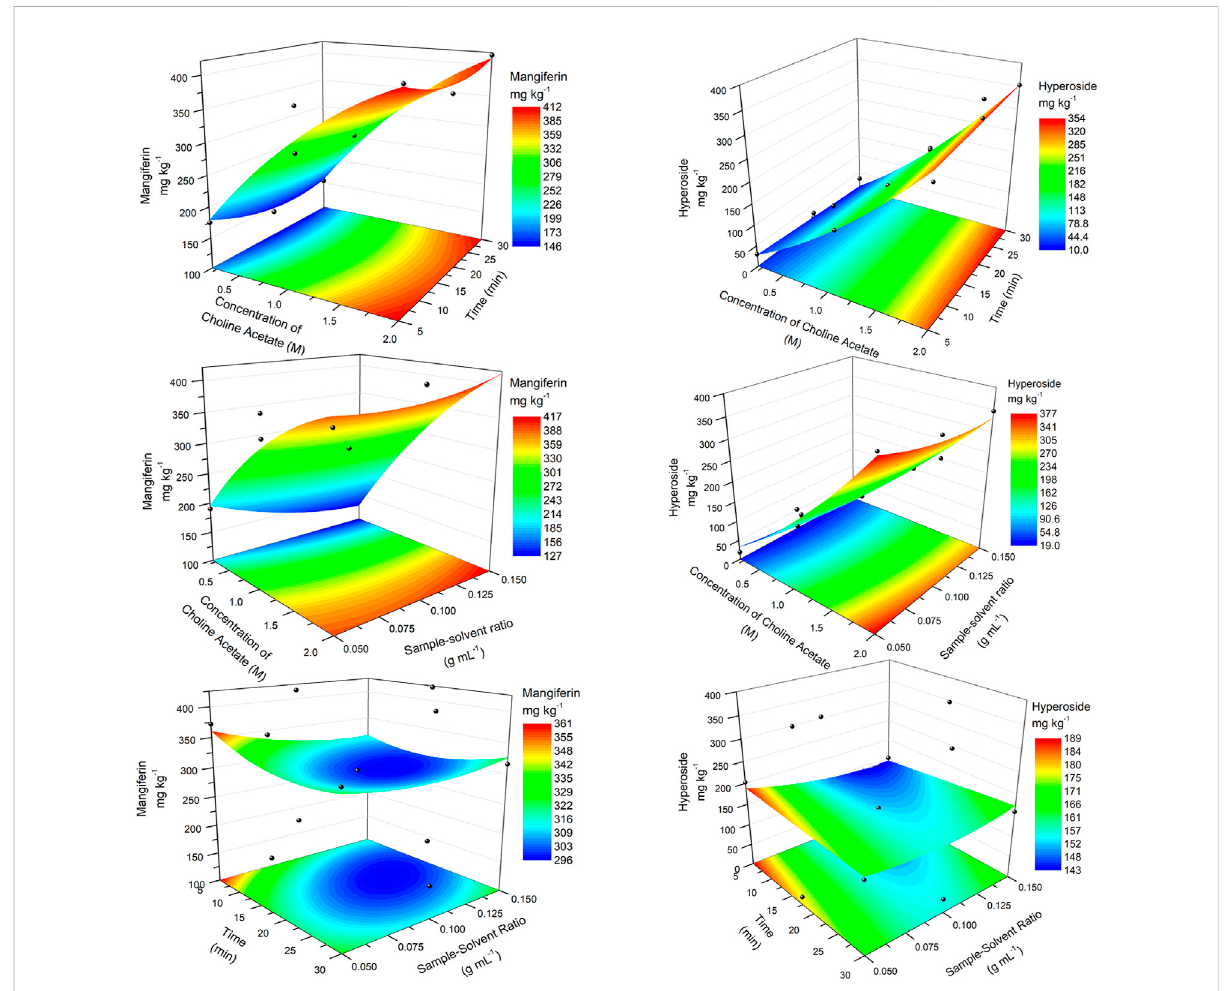
FIGURE 3 RSM plots for the optimization of the extraction of mangiferin (left) and hyperoside (right) using choline acetate ionic